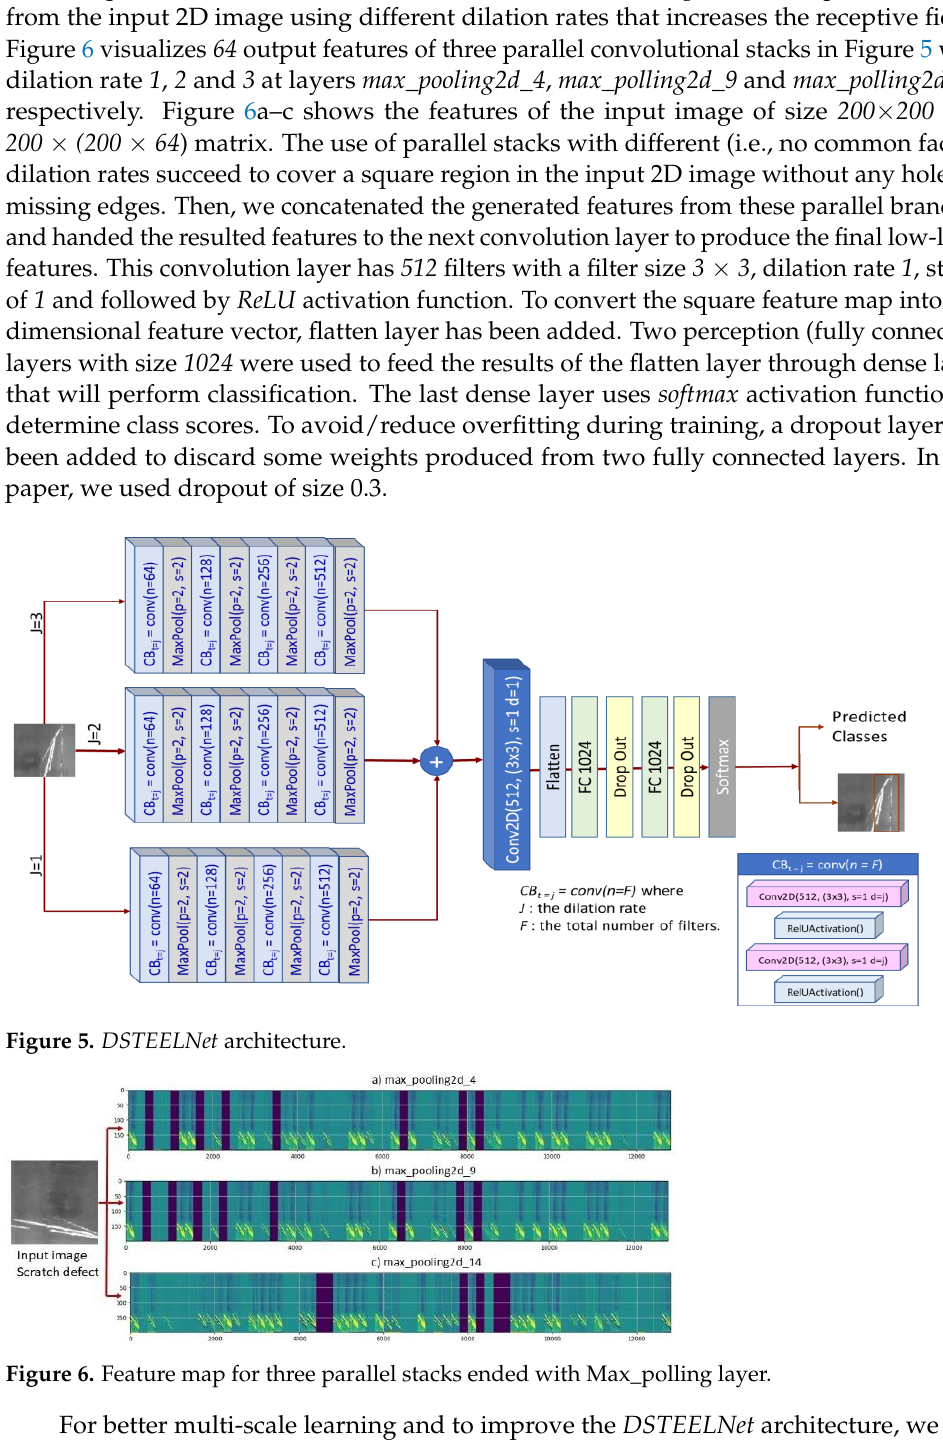
Figure 6. Feature map for three parallel stacks ended with Max_polling layer. For better multi-scale learning and to improve the DSTEELNet architecture, we pro- posed an updated architecture called ( DSTEELNet-ASPP) . It replaced the Conv2D layer after concatenating the features from the parallel stacks in DSTEELNet in Figure 5 by an atrous spatial pyramid pooling ( ASPP ) module [27]. This module includes four Conv2D layers with different dilation rates 4 , 10 , 16 , 22 , respectively to capture defects of distinct size as shown in Figure 7. Then, we concatenated the generated features from these Conv2D layers and handed the resulted features to the flatten layer in Figure 5 to unstack